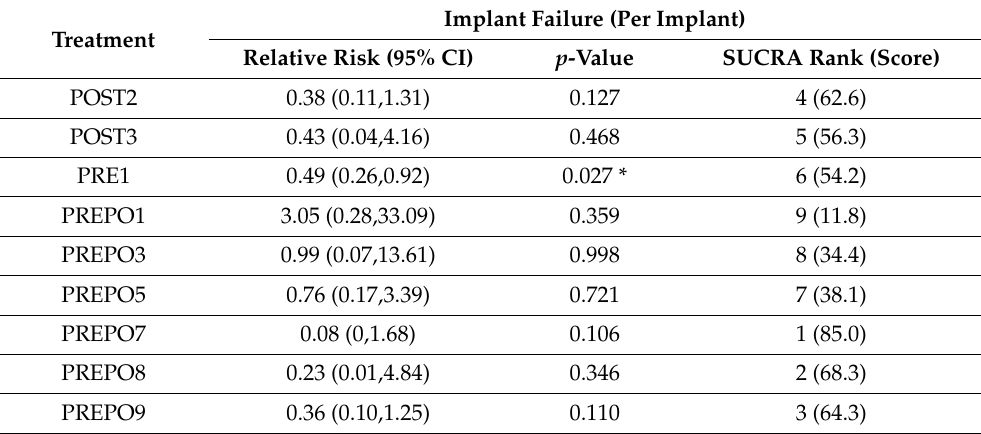
Table 3. Results of network meta-analysis: implant failure (per implant).